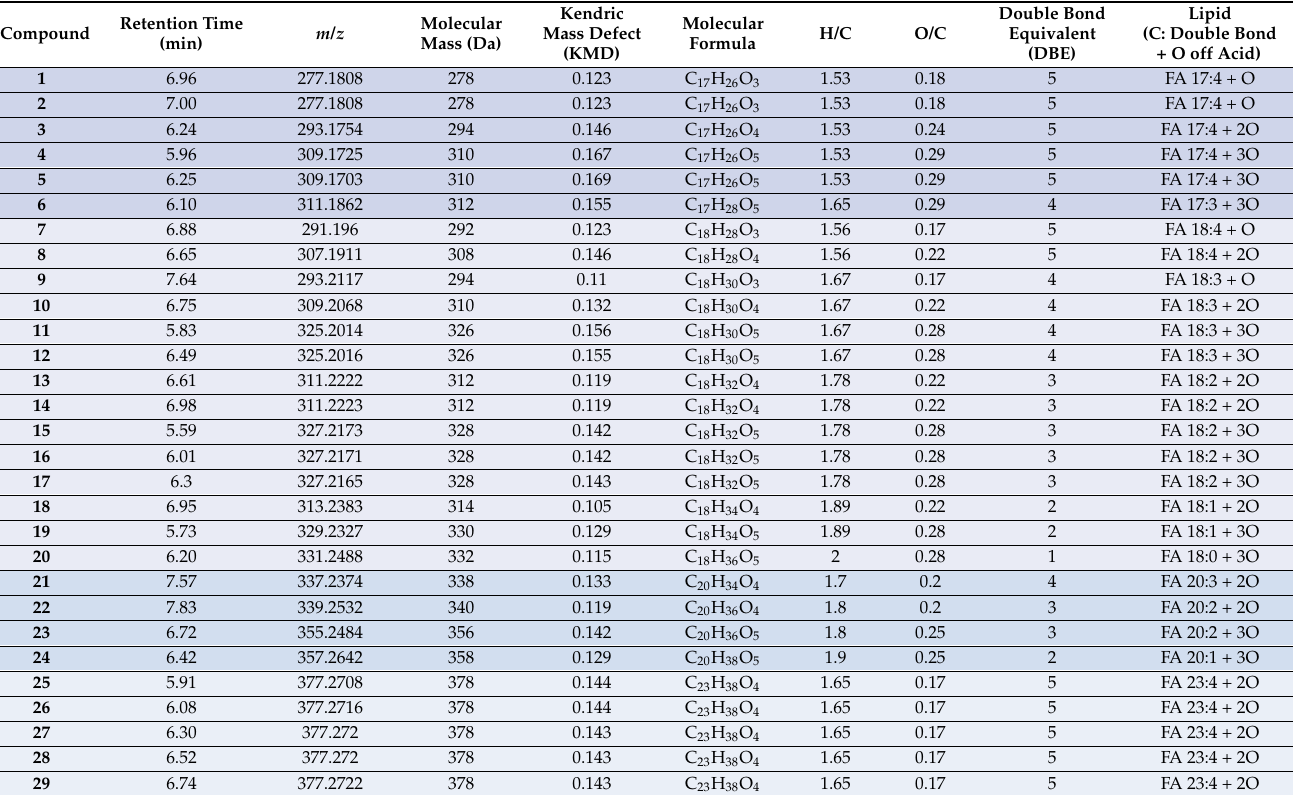
Table 2. Characterization of lipid molecules classified by the homologous carbon series. The back- ground colors indicate the different homologous carbon